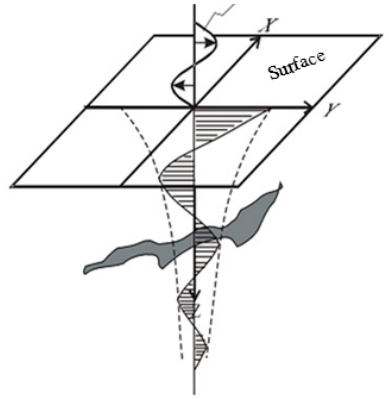
Figure 2. A sketch of the MT detection principle.